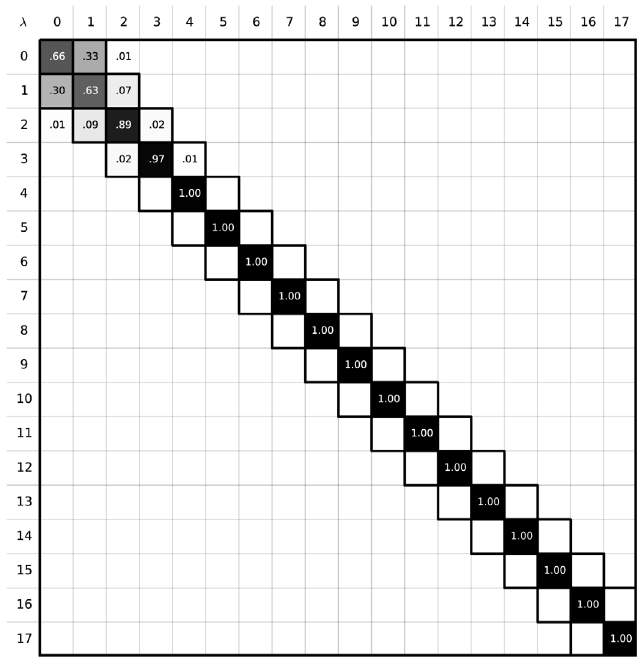
Figure 4. Phase space overlap between the states in the path between IEM and the α -methanol solid. The sum of all the elements in a row should yield 1.0, a probability of 100 %. A good free energy estimate is obtained when the states along the alchemical path contain configurations that can be found in other intermediate states. In these situations, the phase space overlap is non-zero, which results in non- zero off-diagonal elements. Here, however, the phase space overlap plot shows that there is no overlap between the states λ indicating poor free energy estimates will